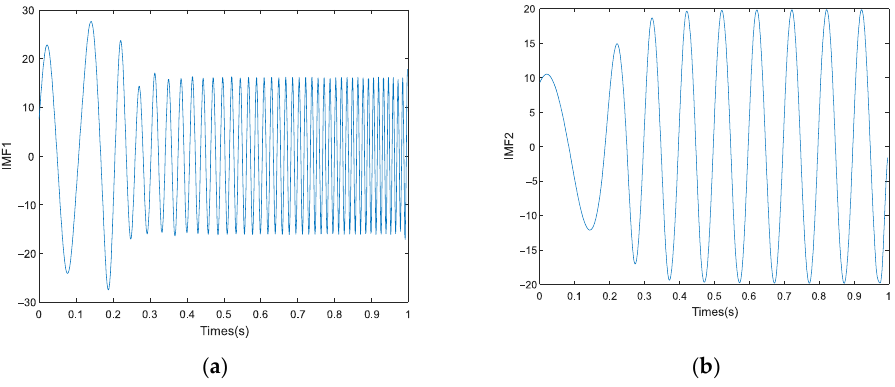
Figure 9. Performance of prediction under the IEMD: ( a ) IMF1; ( b ) IMF2.